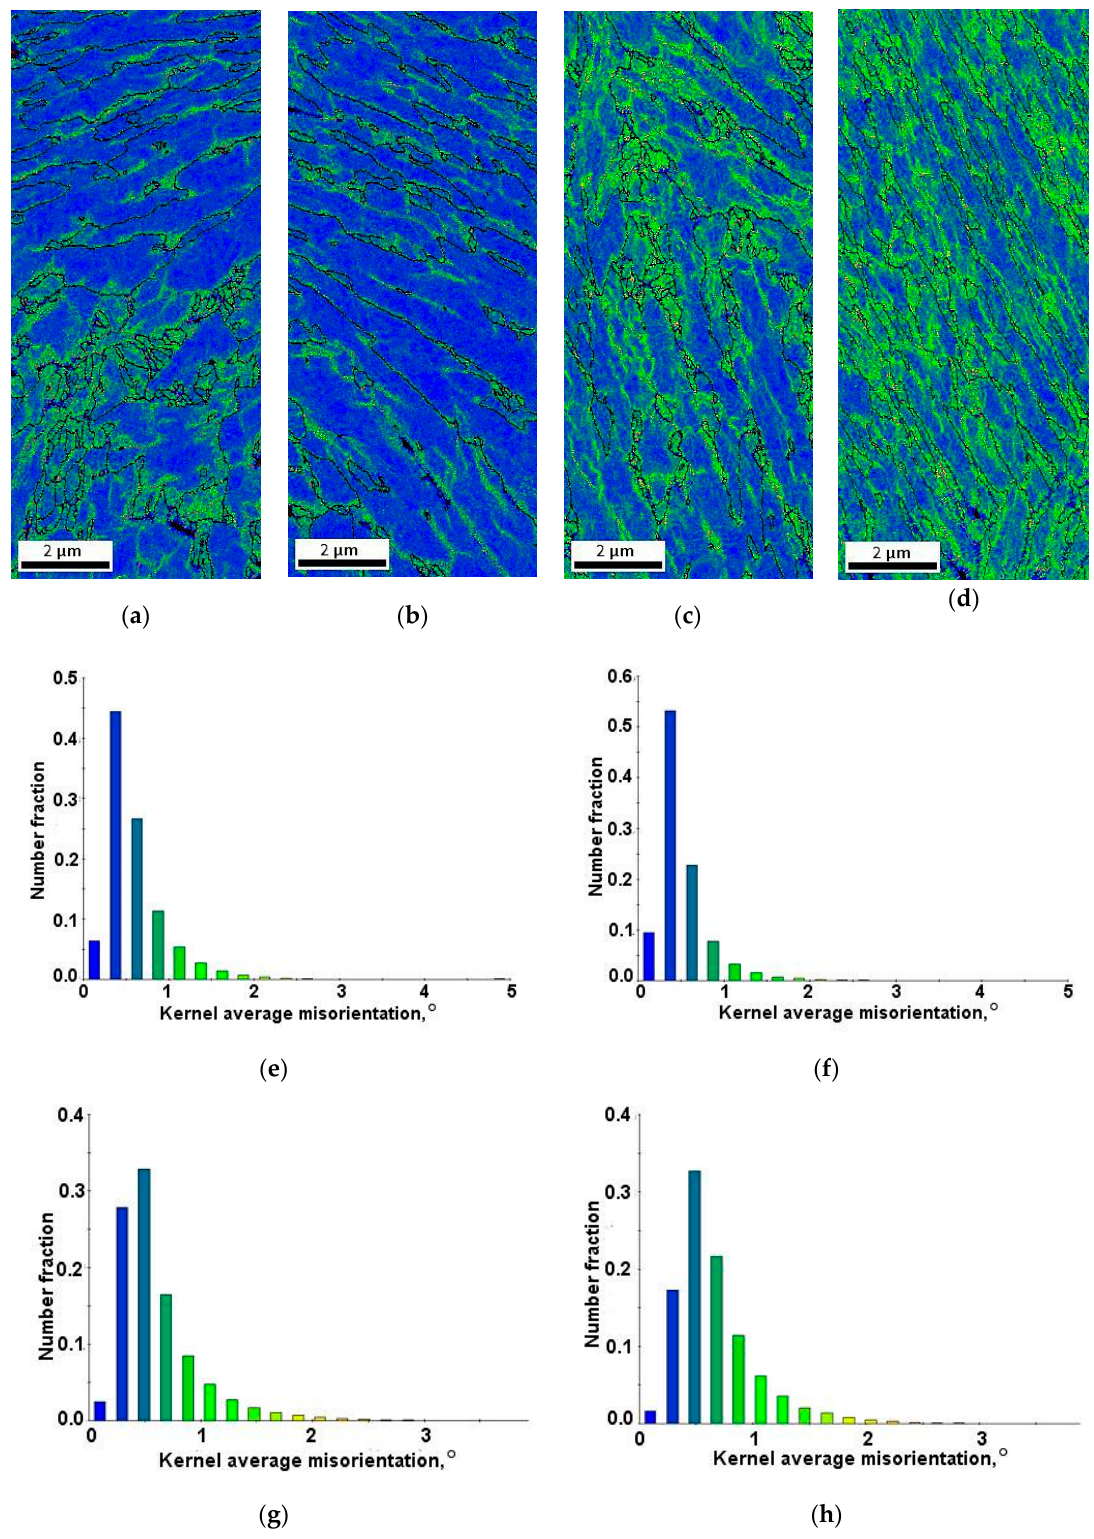
Figure 12. Color-coded kernel average misorientation maps displaying the local strain distribution and kernel average misorientation distribution for the specimens deformed at: 20 °C ( a , e ), 60 °C ( b , f ), 100 °C ( c , g ), 200 °C ( d , h ).